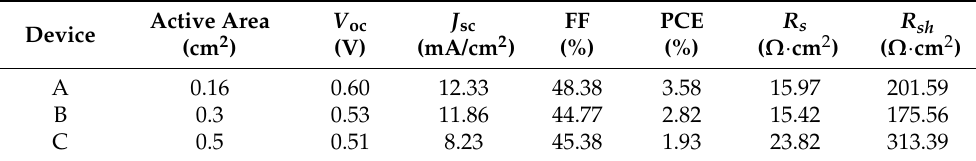
Figure 5. ( a ) J–V curves of ITO/ZnO/CdSe/CdTe/Au with different active areas (Device A—0.16 cm 2 , Device B—0.3 cm 2 , Device C—0.5 cm 2 ) under light (inset is J–V under dark); ( b ) the corresponding external quantum efficiency (EQE) spectrum. Table 2. Summarized performance of NC solar cells with different active areas (Figure 5).